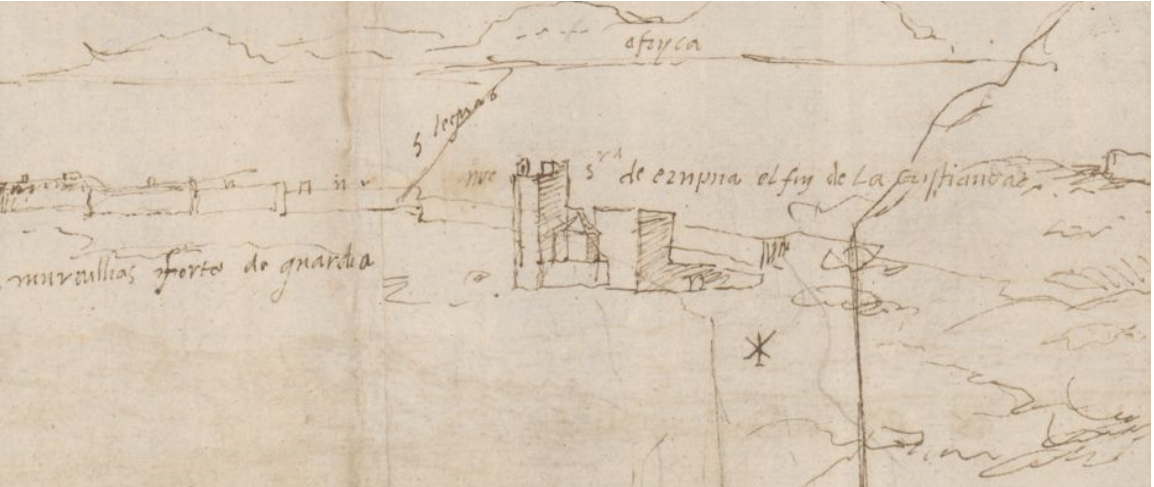
Figure 16. Nuestra Señora de Europa: el fin de la cristiandad . Detail from 1567 sketch of Gibraltar by Anton van den Wyngaerde. Österreichiche Nationalbibliothek, Vienna, Cod. Min. 41, f. 65v [© Österreichiche Nationalbibliothek, Vienna].